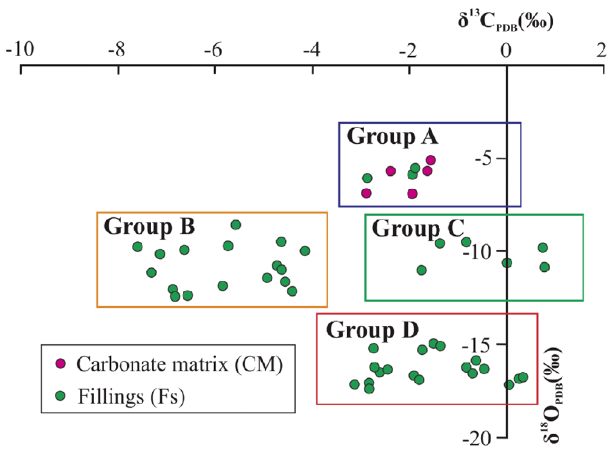
Figure 10. Distribution characteristics of carbon and oxygen isotopes for Groups A, B, C, and